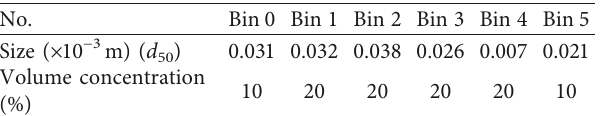
Figure 1: Three-dimensional geometry and grid measurements with meshing. (a) geometry; (b) × 20 times; (c) × 40 times; (d) × 30 times. Table 1: Particle size